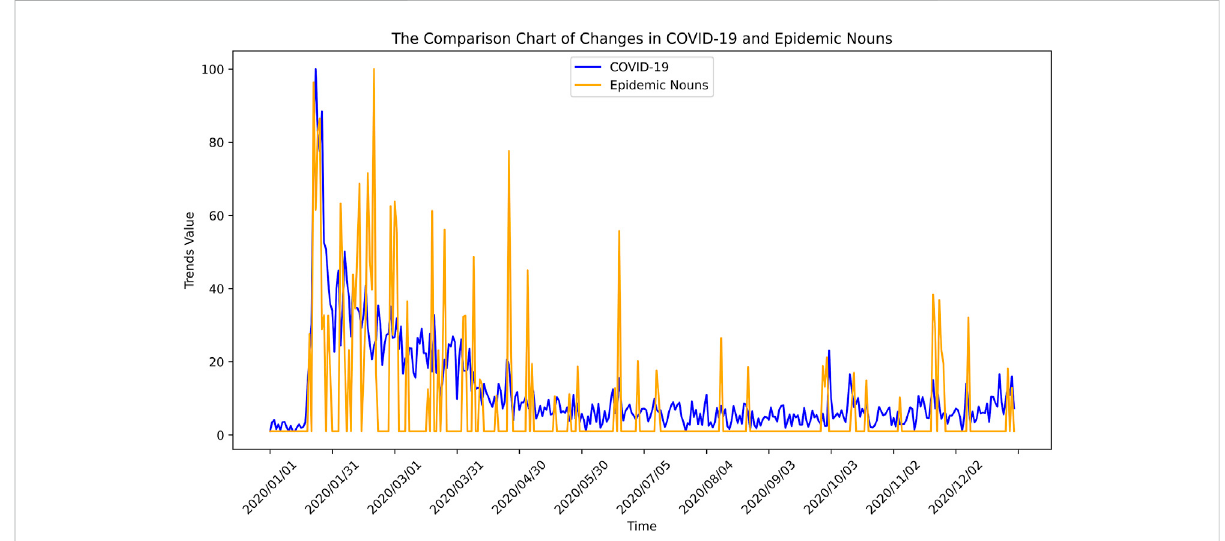
FIGURE 6 The comparison chart of changes in the attention of COVID-19 and epidemic nouns.